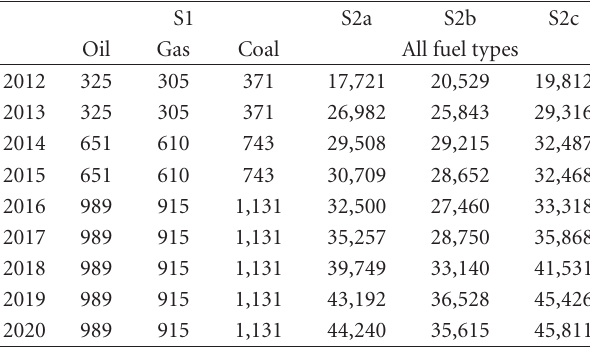
Table 3: E3MG carbon tax inputs (JPY/toe).